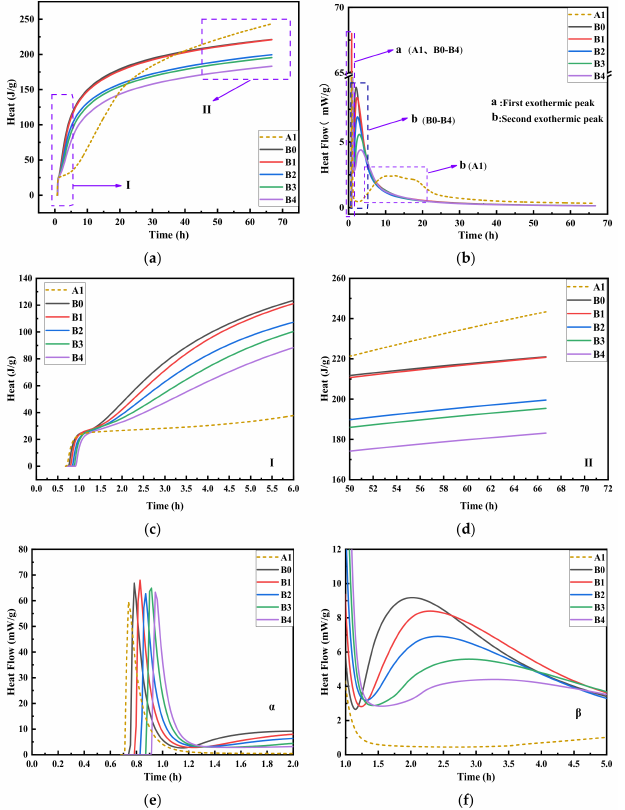
Figure 13. Hydration exothermic behavior of paste with different RCP contents. (( a ) Cumula- tive hydration heat, ( b ) Hydration heat flow, ( c ) Hydration heat for I, ( d ) Hydration heat for II, ( e ) Hydration heat flow for A (First exothermic peak), ( f ) Hydration heat flow for β (Second exother- mic